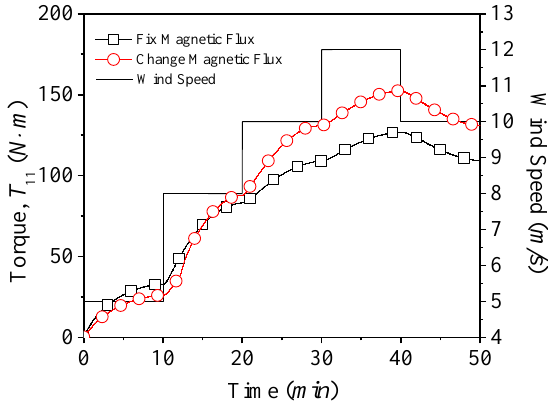
Figure 12. Torque variation for the output shaft.